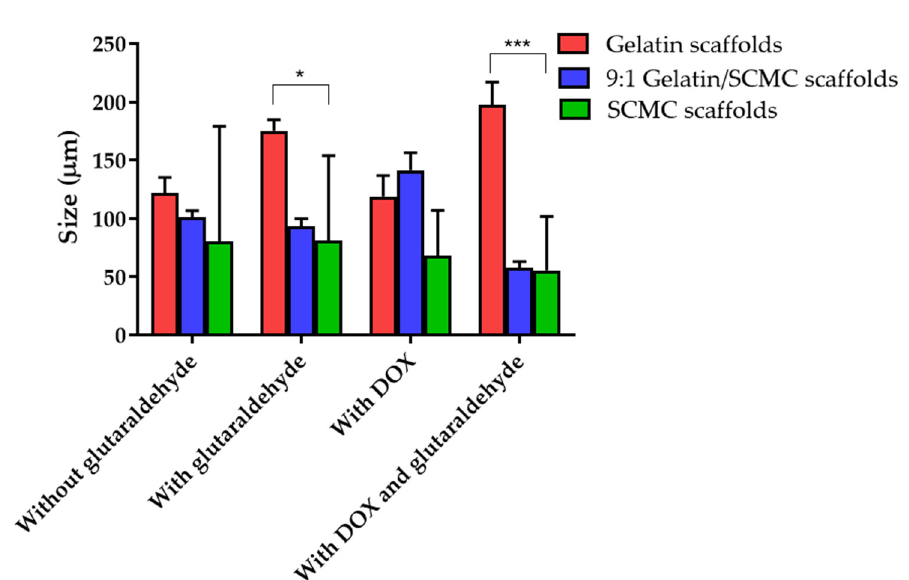
Figure 3. SEM images of hydrogel porous scaffolds made from solution of ( A ) 2% w / v SCMC solution (100 × ); ( B ) 2% w / v SCMC and 2% glutaraldehyde (100 × ); ( C ) 2% w / v SCMC and DOX (100 × ) and ( D ) 2% w / v SCMC solution, DOX, and 2% glutaraldehyde (100×).